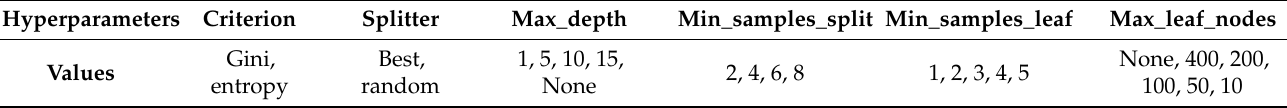
Table 7. Hyperparameters used during calibration with